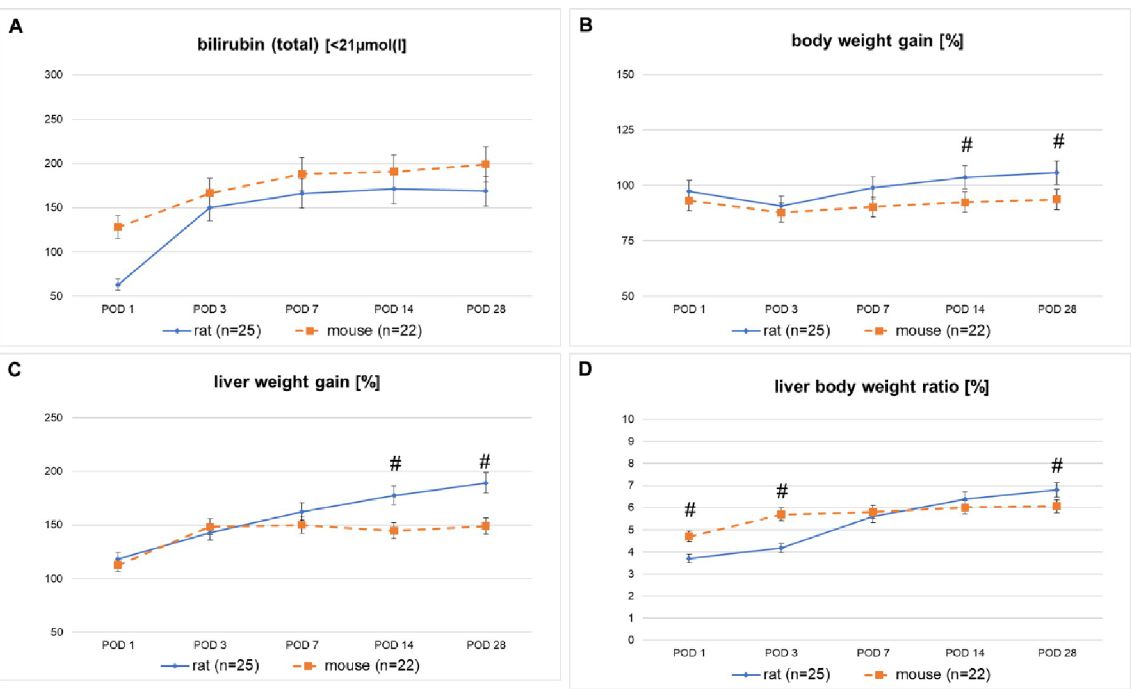
Fig 1. A-D: Results of bilirubin (total) in serum, and the liver and body weight gain with the related liver body weight ratio of rats and mice after tBDT.